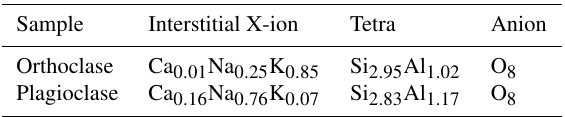
Table 5. Structural formulae of feldspar sample calculated from XRF analysis.